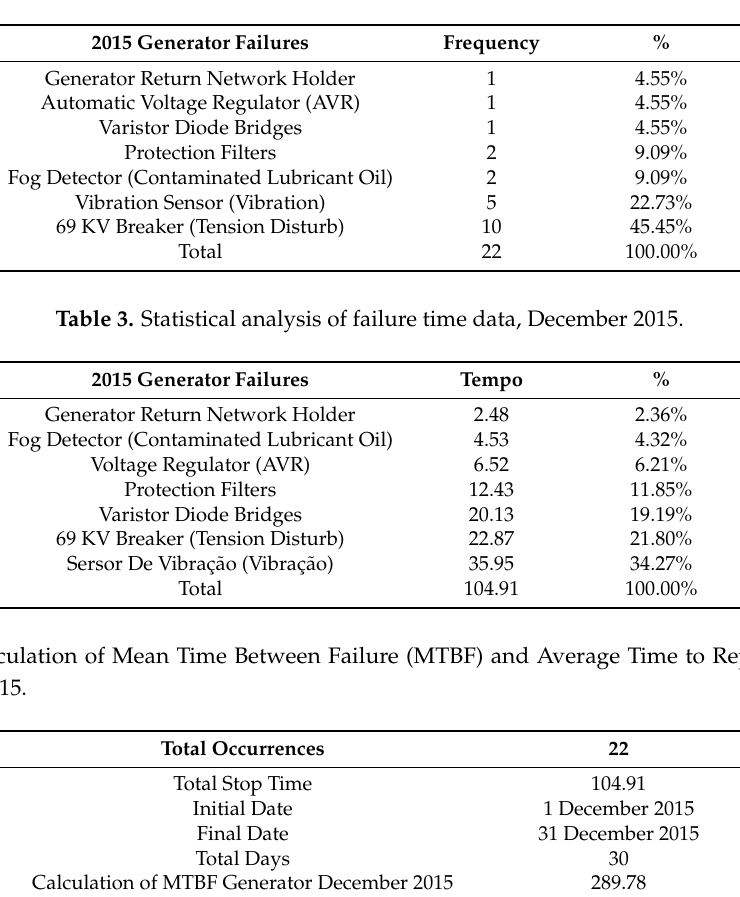
Table 2. Statistical data of failure frequencies, December 2015.